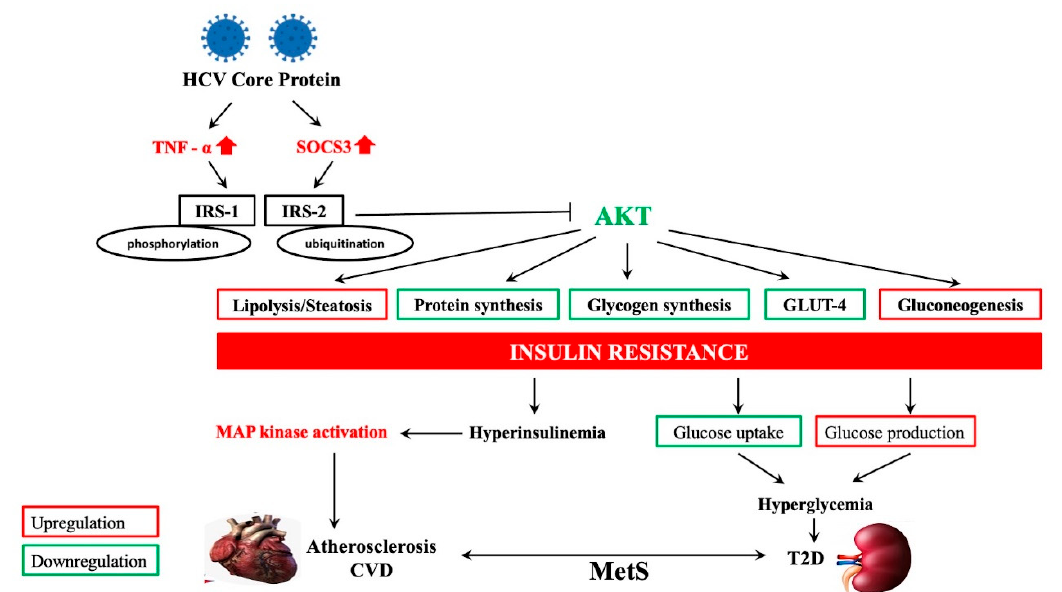
Figure 2. Extrahepatic disorders associated with hepatitis C virus. Red and green illustrate upregulation and downregula- tion, respectively. HCV: hepatitis C virus; TNF- α : tumor necrosis factor alpha; SOCS3: suppressor of cytokine signaling 3; IRS-1: insulin receptor substrate signaling 1; IRS-2: insulin receptor substrate signaling 2; AKT: protein kinase B or Akt signaling pathway; MAPK: mitogen-activated protein kinase signaling pathway; CVD: cardiovascular disease; MetS: metabolic syndrome; T2D: type 2